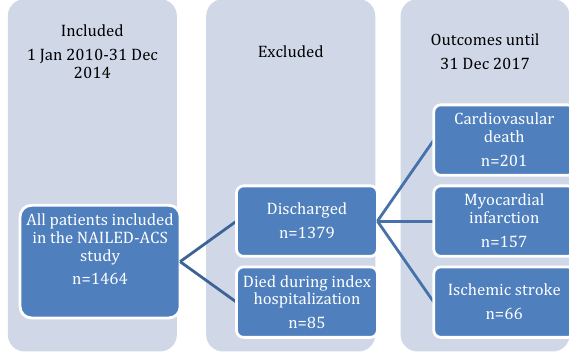
Figure 1. Study flow